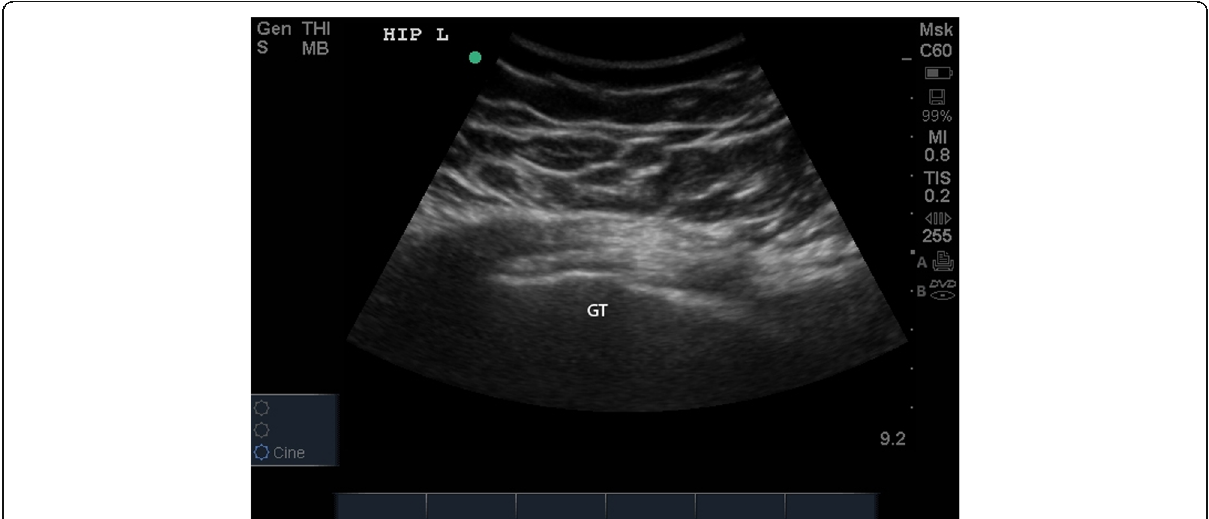
Fig. 1 Ultrasound of the greater trochanter (GT) and inflamed